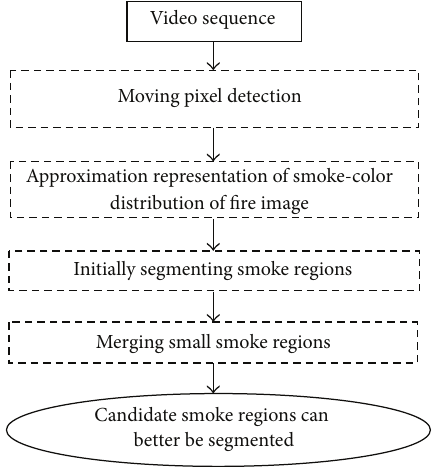
Figure 1: The basic process of the proposed